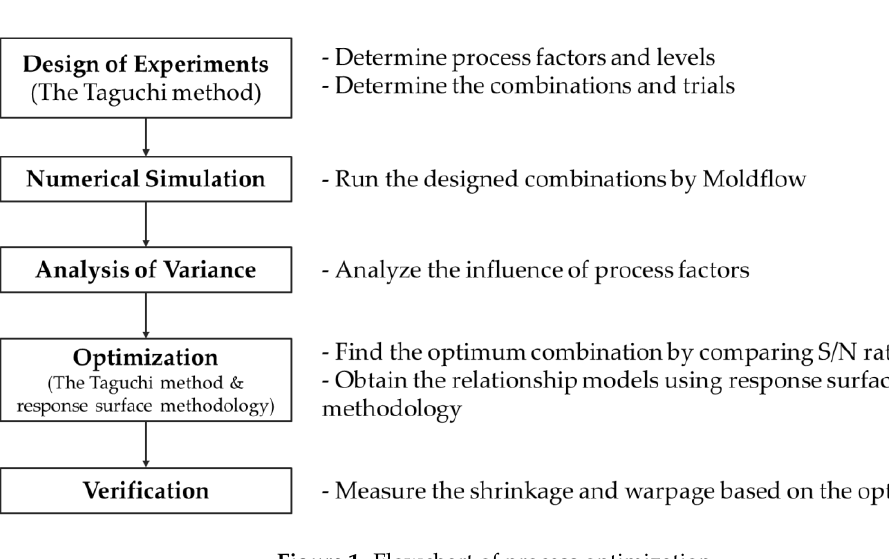
Figure 1. Flowchart of process optimization.